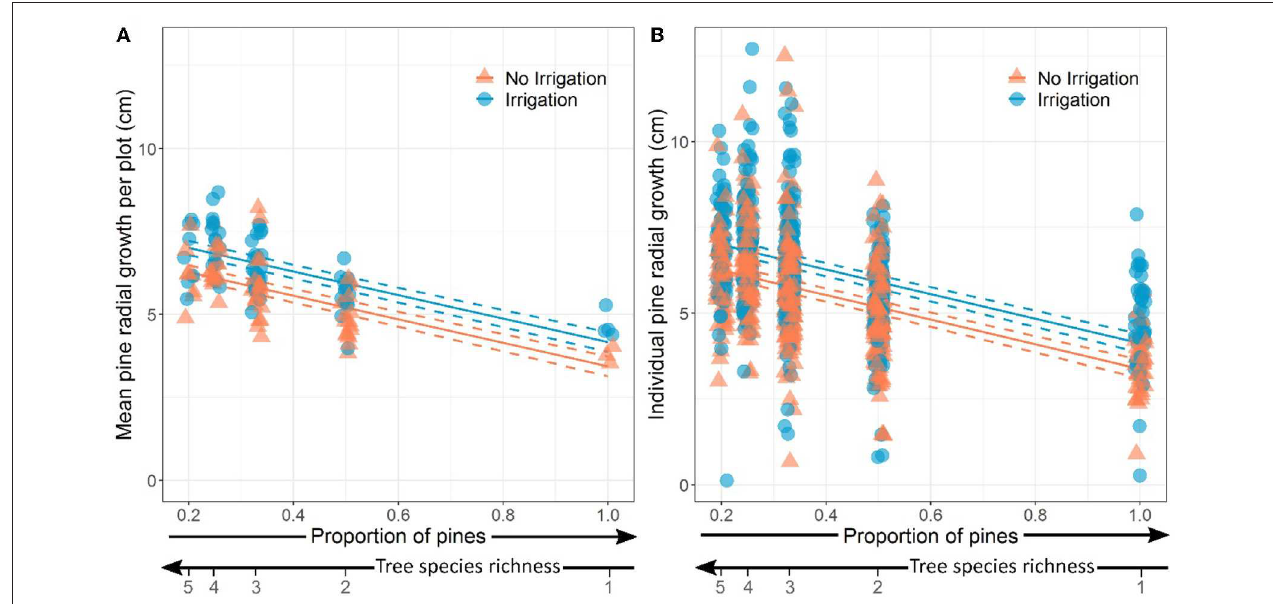
FIGURE 3 | Effects of proportion of pines (inversely proportional to tree species richness) and water treatment in the plots on (A) mean pine radial growth (plot level) and (B) individual pine radial growth. In both panels, dots have been slightly spread around the value of x (proportion of pines) for the sake of visibility. Model predictions and standard-errors are represented by solid and dashed lines, respectively.